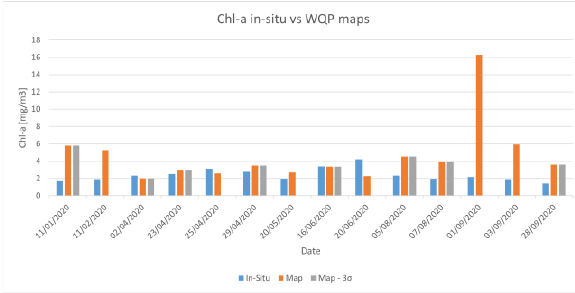
Figure 1. Comparison in-situ measurements and SIMILE remote sensing based Chl-a estimates, before (orange) and after (grey) outlier rejection